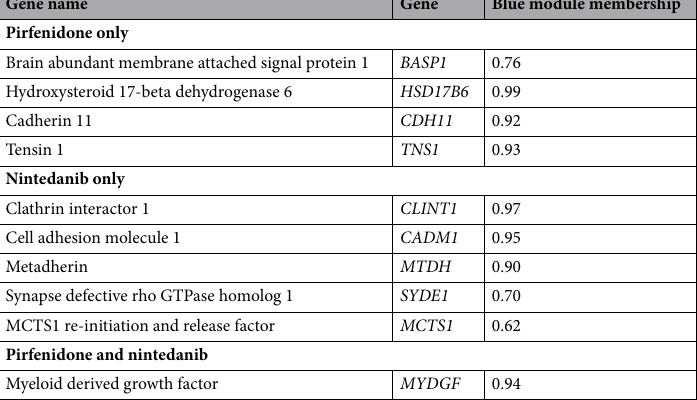
Table 1. Novel genes targeting pirfenidone, nintedanib, or both pirfenidone and nintedanib. Novel is defined as not previously identified in known TGFβ1 signaling